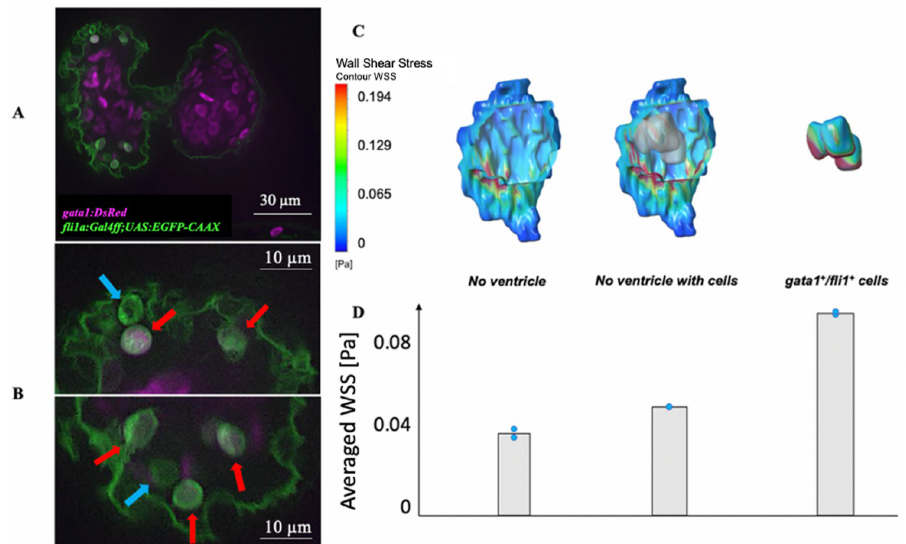
Fig 5. Effect of trapped fli1 + /gata1 + cells on the endocardial WSS. (A) Confocal image of a 3 dpf zebrafish embryonic heart that was crossed between the Tg(fli1a : Gal4ff;UAS : EGFP-CAAX) line and the Tg(gata1 : DsRed) line. (B) Close up of the image showing several wobbling cells appear to be trapped within intra-trabecular spaces from the image. Some of these cells were fli1 + (blue arrows), while some were gata1 + /fli1 + (red arrows). These were thus hypothesized to be developing hematopoietic cells. (C) Flow simulation WSS results with and without the hematopoietic cells at end-systole, demonstrating that the cells elevated endocardial WSS. (D) Average WSS magnitude (n = 2) from the simulations, calculated by averaging both spatially (over entire endocardial surface) and temporally (over entire cardiac cycle).